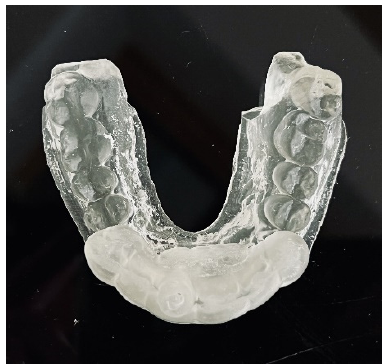
Figure 14. The three-dimensional printed guide and the patient’s model enabled us to check the accuracy of the guide and to practise proper drill insertion.